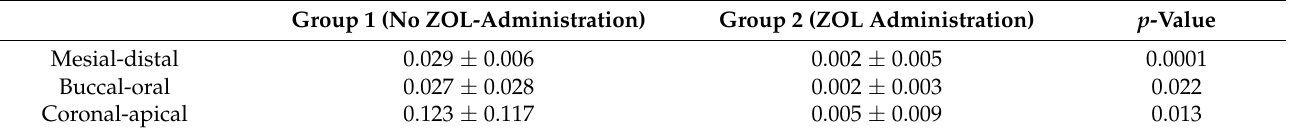
Table 2. Mean tooth growth in mm/day for the three measuring axes evaluated in this investigation.